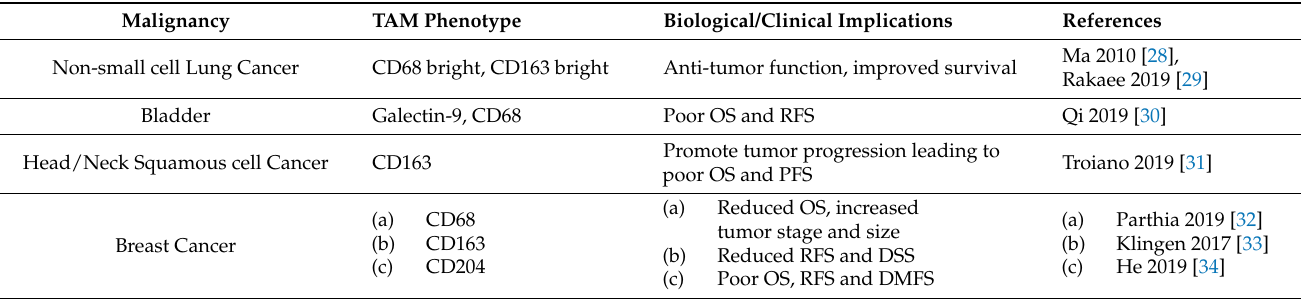
Table 1. Comparison of the characteristics of TAMs in solid tumors and MM; NR = not re- ported, PFS = progression-free survival, RFS = relapse-free survival, DSS = disease-specific survival, DMFS = distant-metastasis-free survival, and OS= overall